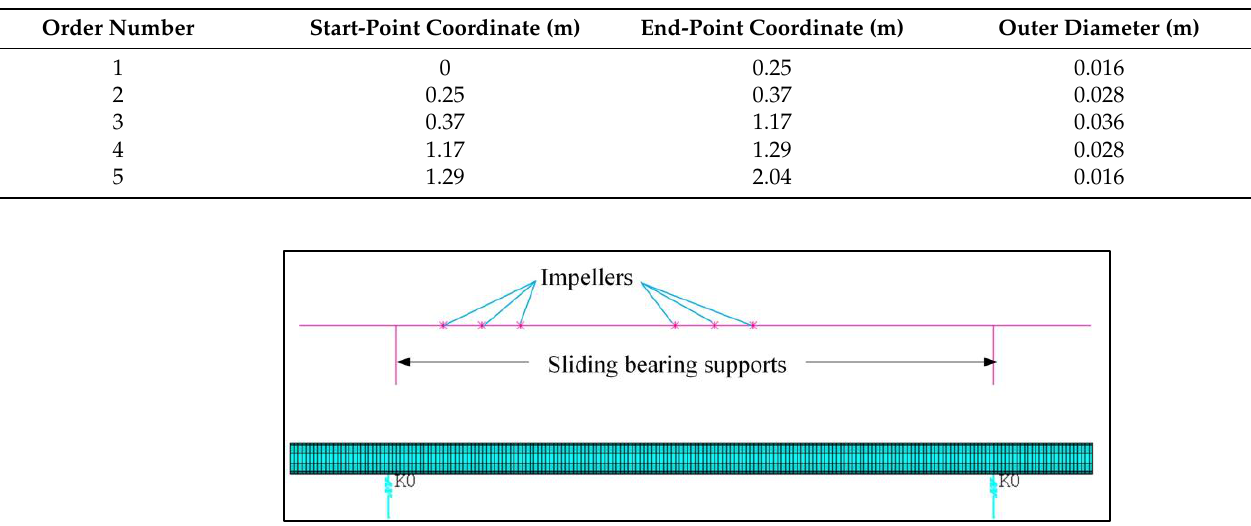
Table 3. Dimension parameters of the rotor shaft section.